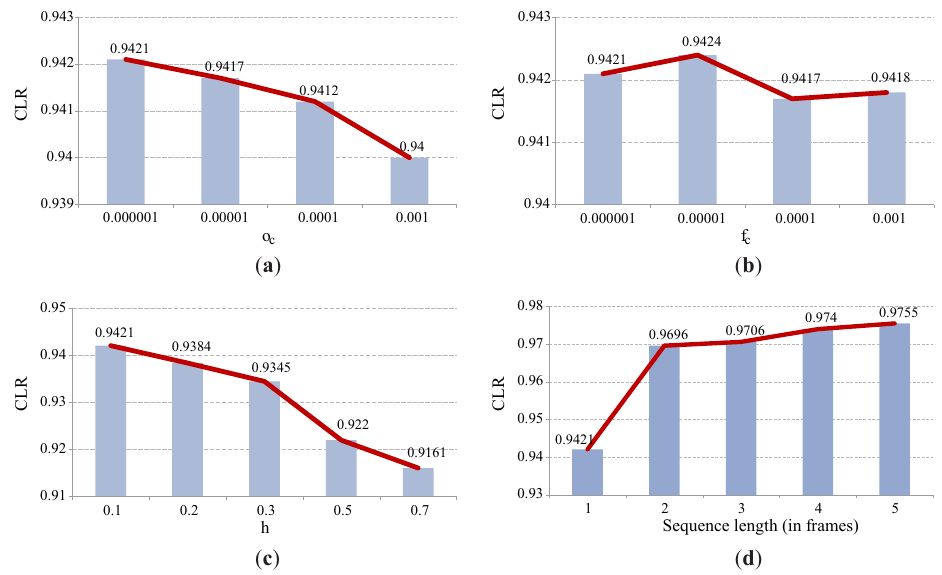
Figure 14. Impact of various hyper-parameters of the proposed technique on the labeling accuracy (measured in terms of the CLR). The results were generated on the indoor dataset and, except for the graph in the lower right corner, were computed using a sequence length of one. ( a ) impact of the overlap-cost parameter o c , ( b ) impact of fraction-cost parameter f c , ( c ) impact of the function drop rate h , ( d ) impact of the sequence